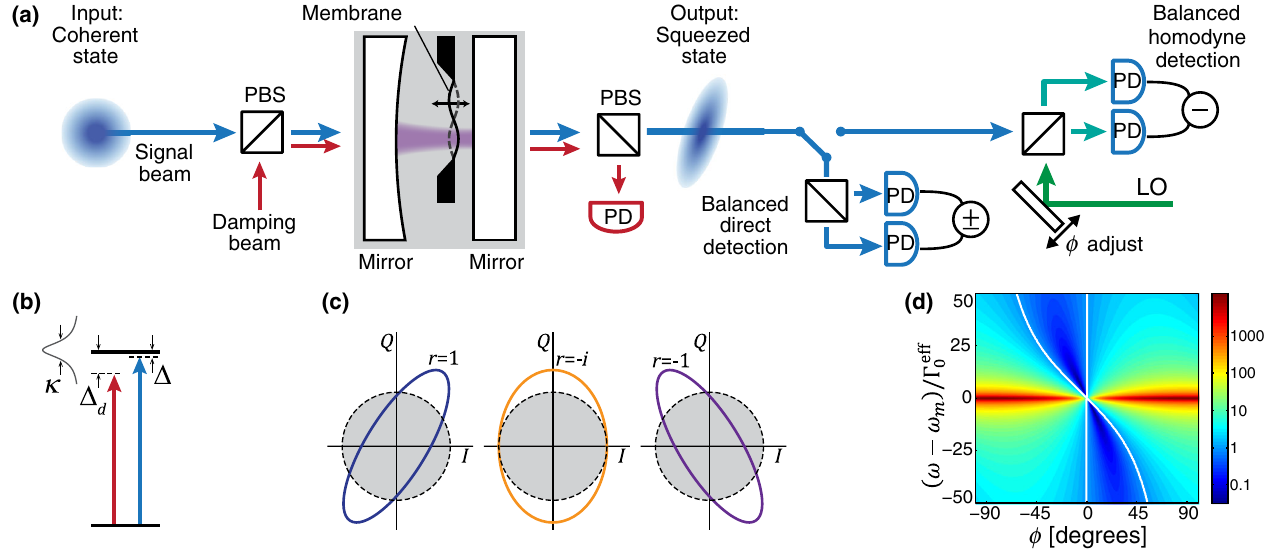
FIG. 1. Experimental diagram for optomechanical squeezing. (a) The signal beam (blue arrows) enters the optomechanical cavity as a coherent state. After the optomechanical interaction, a squeezed state emerges. The signal beam is detected either with balanced direct photodetection or with balanced homodyne detection by mixing with an optical local oscillator (LO) (green arrow). A weaker damping beam (red arrows) orthogonally polarized to the signal beam is also injected into the cavity. The two beams are combined before the cavity and separated after the cavity with polarizing beam splitters (PBS) and detected with photodetectors (PD). (b) Signal- (cid:4) (cid:2)X phase-space distributions of the signal beam and damping-beam detunings from the cavity resonance. (c) Representative (cid:2)X I Q for real and imaginary values of r , the Kerr parameter. The dashed circle represents the variance of the Gaussian noise distribution of the vacuum state. Distributions inside the dashed circle represent squeezed states. (d) Simulated signal-beam quadrature spectrum for (cid:1) ¼ 0 in the idealized case of zero temperature and no optical loss. Otherwise, Heisenberg-Langevin simulation parameters ffiffiffiffi p (cid:2) N = 2 (cid:4) ¼ 2 : 6 kHz , ! = 2 (cid:4) ¼ 1 : 53 MHz , and g = 2 (cid:4) ¼ 350 kHz . The are set to experimental values: (cid:3)= 2 (cid:4) ¼ 1 : 7 MHz , (cid:3) eff m 0 0 spectrum is displayed on a logarithmic scale. The region between the white contours is